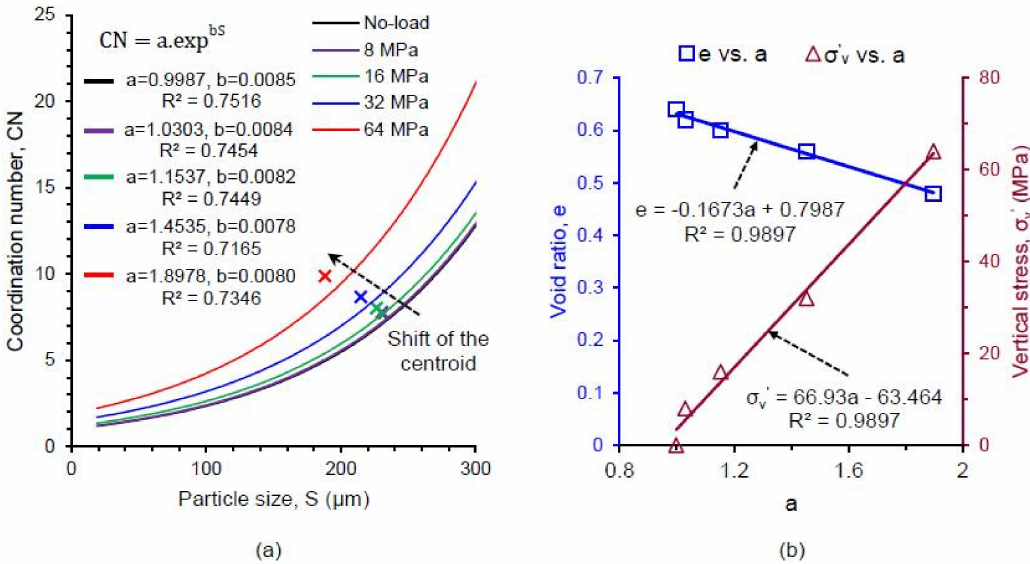
Figure 15. ( a ) Correlation between particle size and coordination number at different vertical stresses for RBS particles; ( b ) Correlation between parameter “ a ”, vertical stress and void ratio of RBS particles.